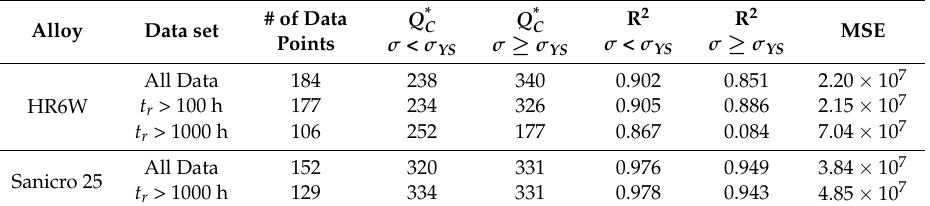
Figure 8. Calculated rupture times for Sanicro 25. Table 11. The effect of removing very-short-term test data on goodness of fit and error.